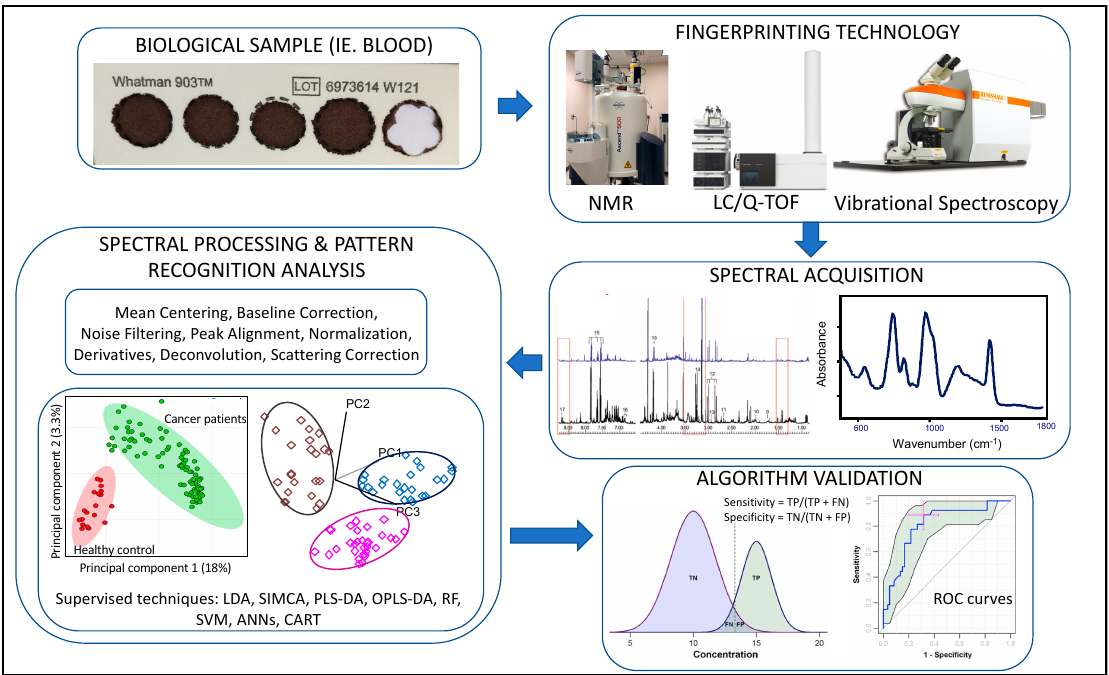
Figure 1 . Untargeted metabolomics approach for differentiating metabolite detection [8,34–36]. Figure 1. Untargeted metabolomics approach for di ff erentiating metabolite detection